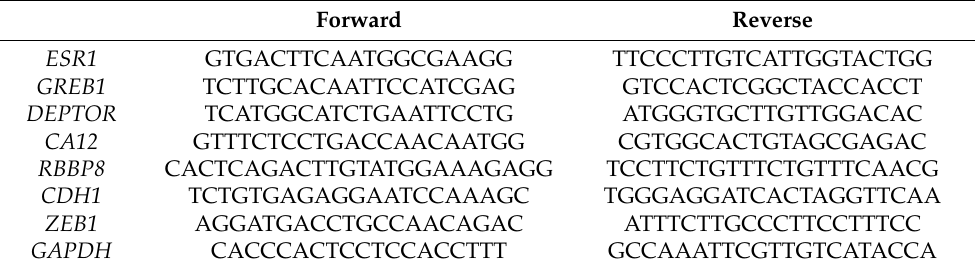
Table 4. Primer sequences for the RT-PCR analysis of